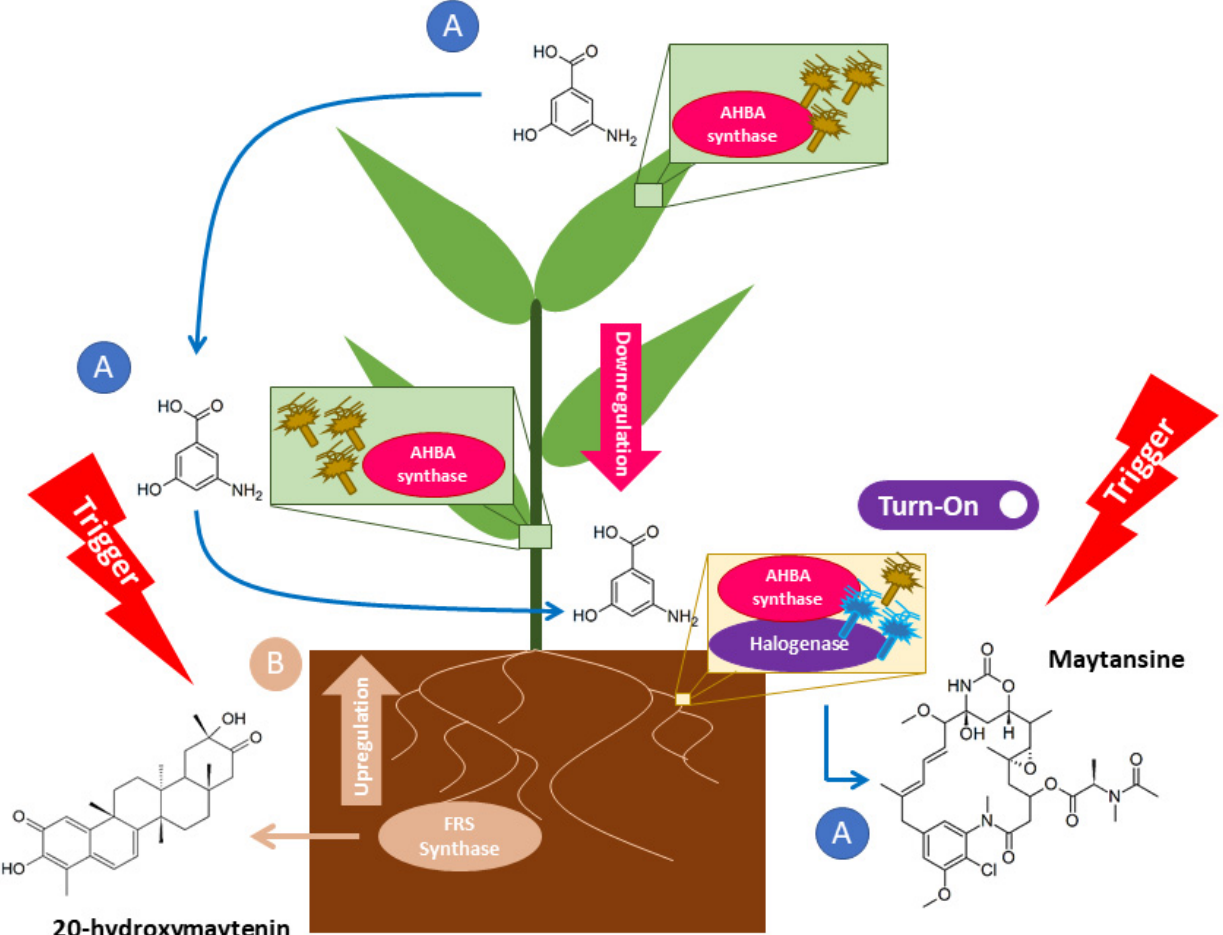
Figure 9. Proposed mechanistic response and relationship between the maytansine biosynthesis from endophytic communities and the 20-hydroxymaytenin biosynthesis from G. heterophylla , a plant host. A indicates the downregulation of the AHBA synthase gene and the activation of the halogenase from endophytes in different organs of G. heterophylla , and B indicates the upregulation of the FRS gene from the 20-hydroxymaytenin biosynthesis in the G. heterophylla roots. Blue arrows indicate the flow of AHBA transportation from the leaves to roots.